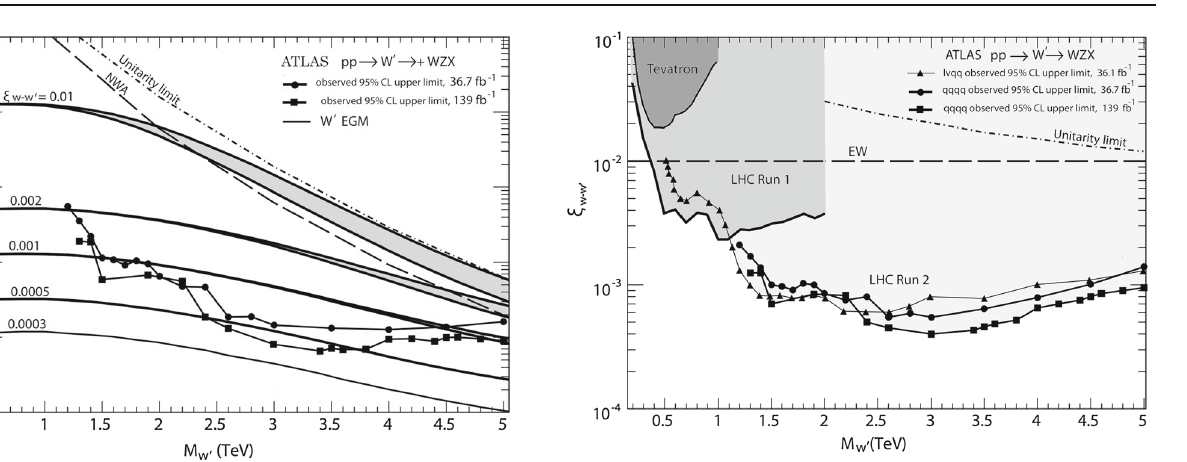
Fig. 3 Observed 95% CL upper limits on the production cross section times the branching fraction, σ 95% × BR ( W (cid:2) → W Z ) , as a function of the W (cid:2) mass, M W (cid:2) , showing ATLAS data on the fully hadronic final states for 36 . 7 fb − 1 [36] and 139 fb − 1 [37]. The theoretical production cross sections σ( pp → W (cid:2) + X ) × BR ( W (cid:2) → W Z ) for the EGM are calculated from PYTHIA with a W (cid:2) boson mass-dependent K -factor used to correct for NNLO QCD effects, and given by solid curves, for mixing factor ξ W − W (cid:2) ranging from 10 − 2 and down to 3 · 10 − 4 . The shaded bands are defined like in Fig. 1. The area lying below the long-dashed curve labelled NWA corresponds to the region where the narrow-resonance assumption is satisfied. The lower boundary of the region excluded by the unitarity violation arguments is indicated by the dot-dashed curve [40,49]